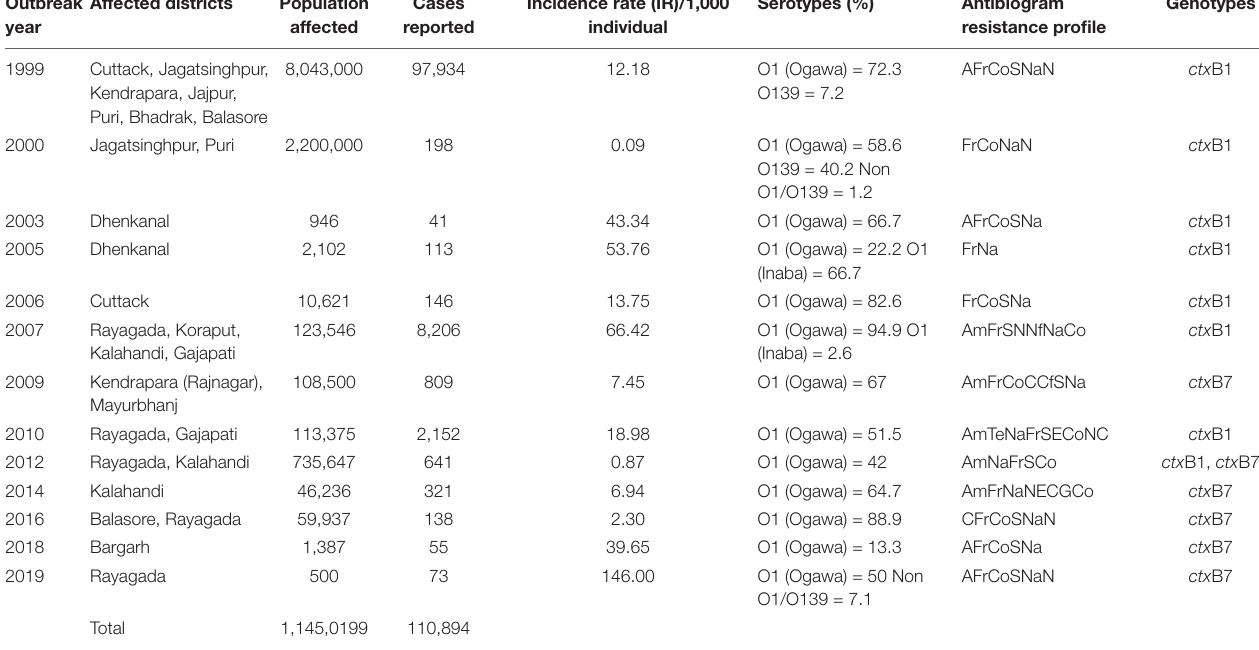
TABLE 2 | Antibiotic resistance profiles with ctx B genotypes of Vibrio cholerae O1 associated with different cholera outbreaks in Odisha: